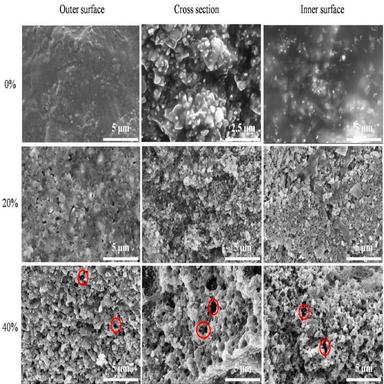
SEM images (outer, inner surface and the cross section) of the resin layer.